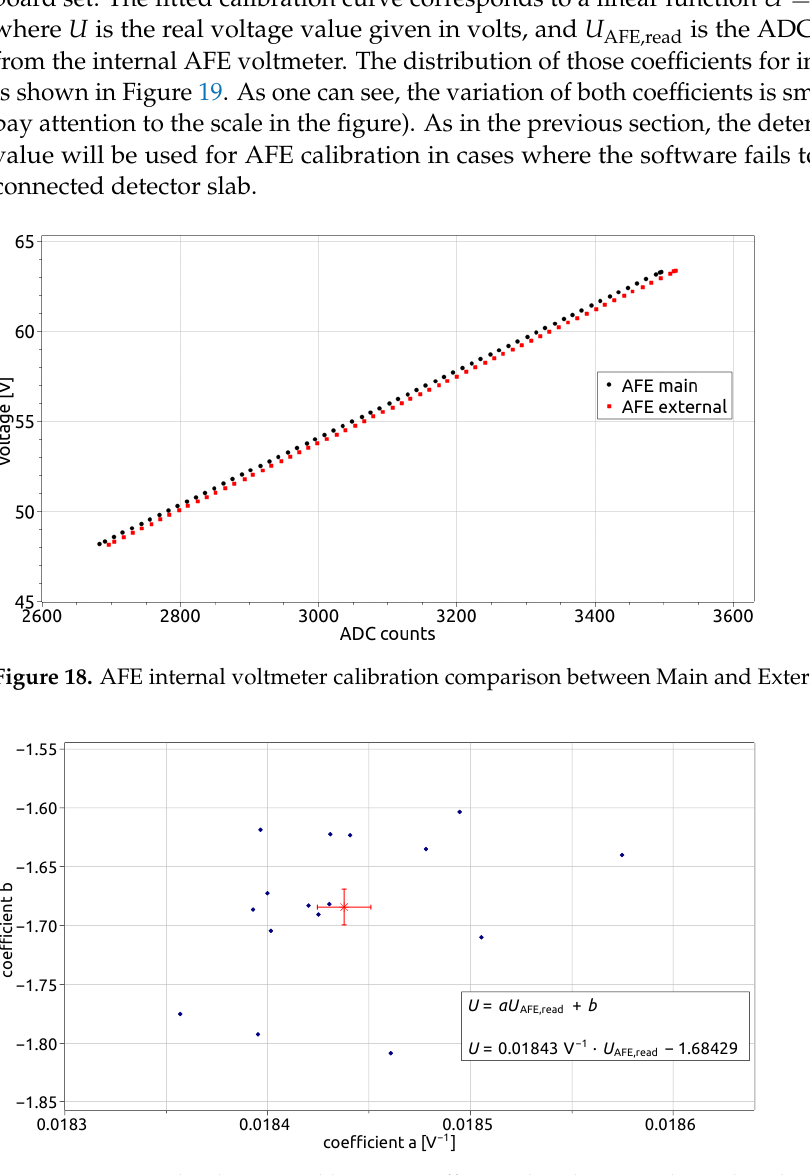
Figure 19. Internal voltmeter calibration coefficient distribution. The scale is limited to a narrow range to show small differences in presented values. The average value is marked with a red